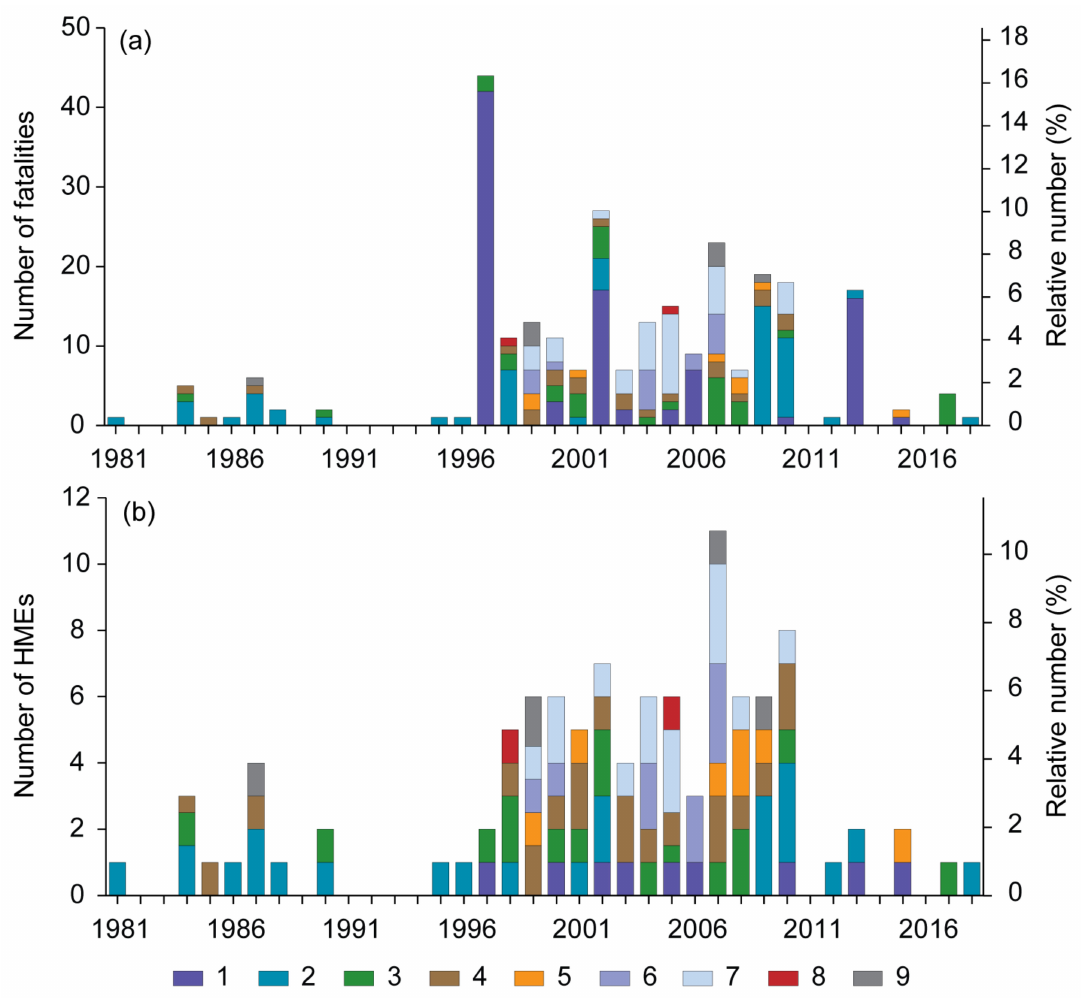
Figure5. Fluctuations( a )in theannual numbersoffatalities and( b )in theannual numbersofHMEs with fatalities in the Czech Republic during the 1981–2018 period: 1—flood, 2—flash flood, 3—windstorm, 4—convective storm, 5—lightning, 6—frost, 7—snow / glaze-ice, 8—heat, 9—other